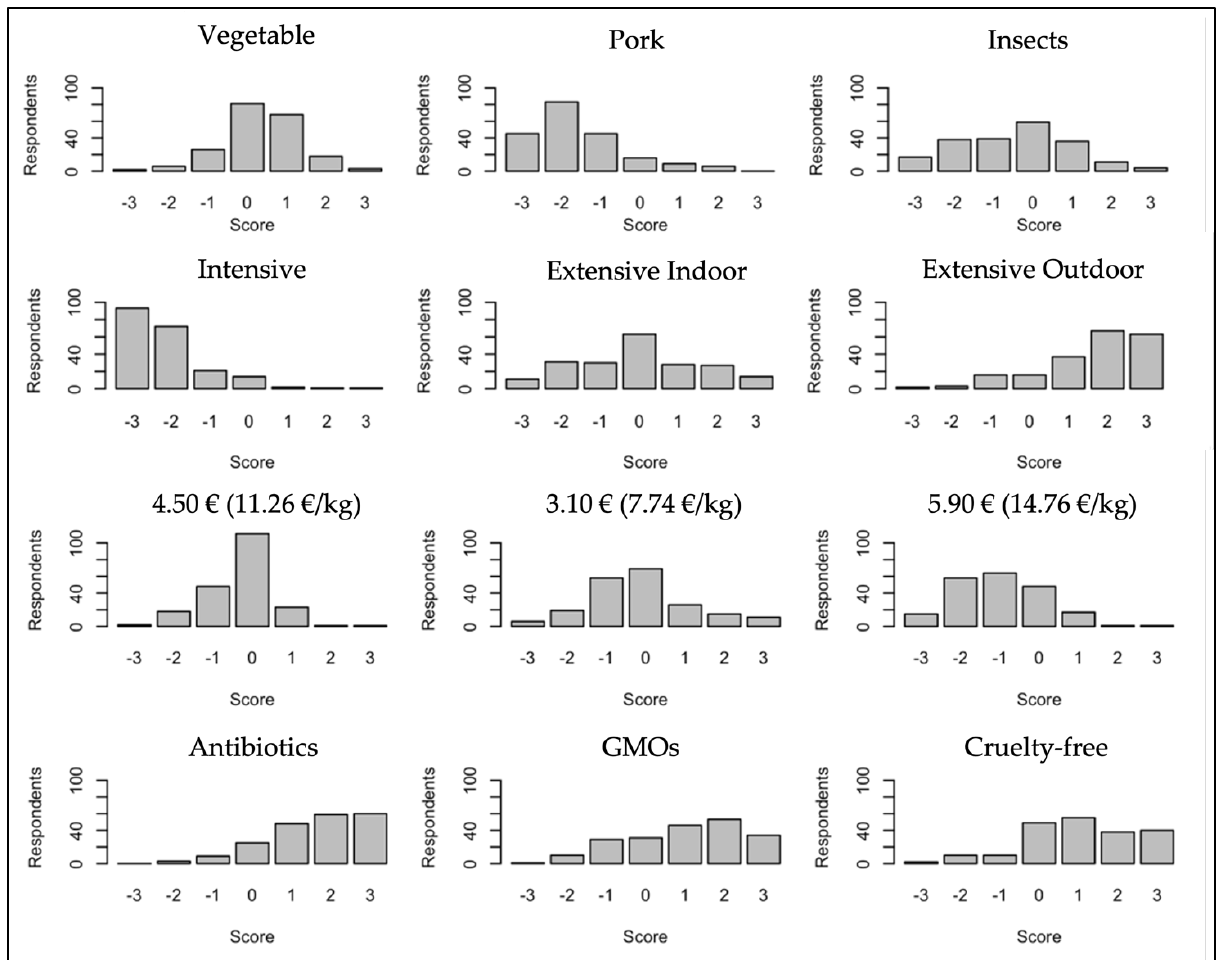
Figure 2. Distributions of best-minus-worst (BW) scores for the 12 levels.